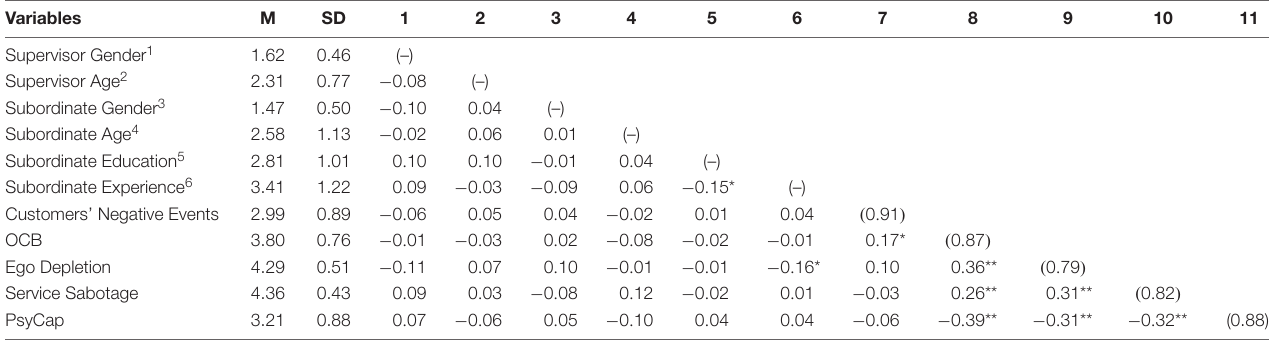
TABLE 1 | Intercorrelations, descriptive statistics, and estimated reliabilities among the variables.